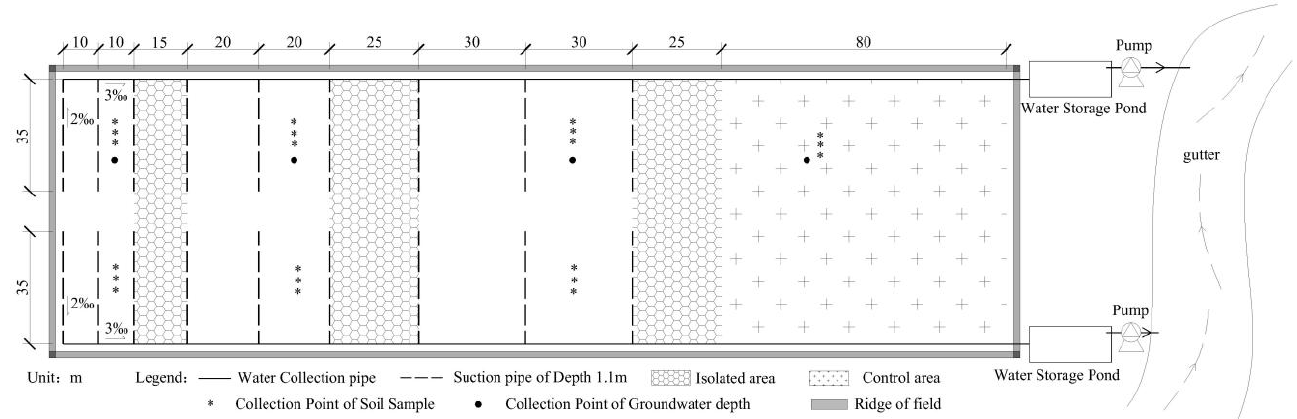
Figure 2. Meteorological data of the test area.